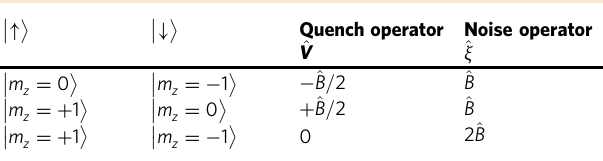
Table 1 Quench operator dependence on subspaces of NV center used to form the sensor qubit, assuming fi xed initial (cid:4) (cid:4) NV state m z ¼ 0